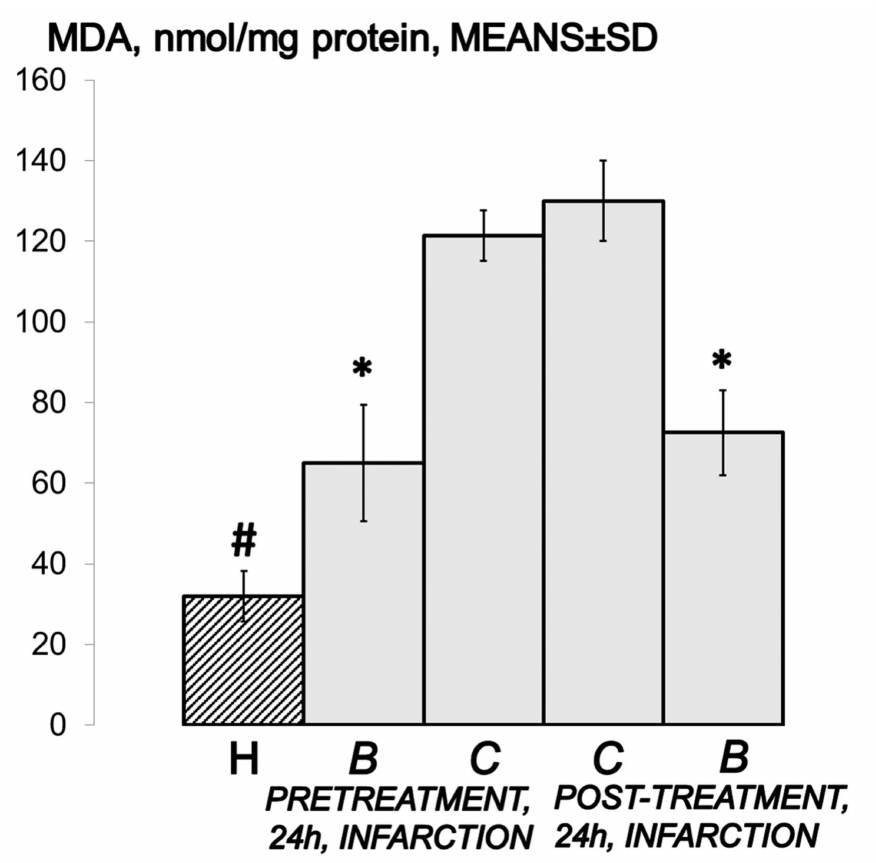
Figure 19. MDA levels in heart tissue. MDA levels in the heart tissue of isoprenaline-treated rats at 24 h after challenge (isoprenaline 75 mg/kg sc) (gray bars), determined by quantifying thiobarbituric acid (TBA) reactivity as malondialdehyde (MDA) equivalents. BPC 157 (10 µ g/kg ip) ( B ) or an equal volume of saline (5 mL/kg ip) (controls) ( C ) was applied to the isoprenaline-treated rats before or after the challenge. Ten rats per each experimental group. * p < 0.05 vs. saline; # p < 0.05 healthy (dashed bar) vs. isoprenaline-treated rats